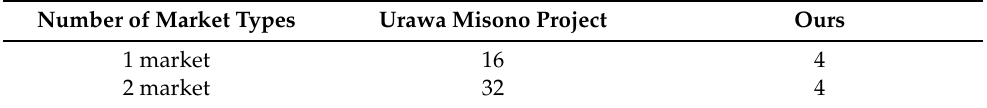
Table 9. Average transactions per